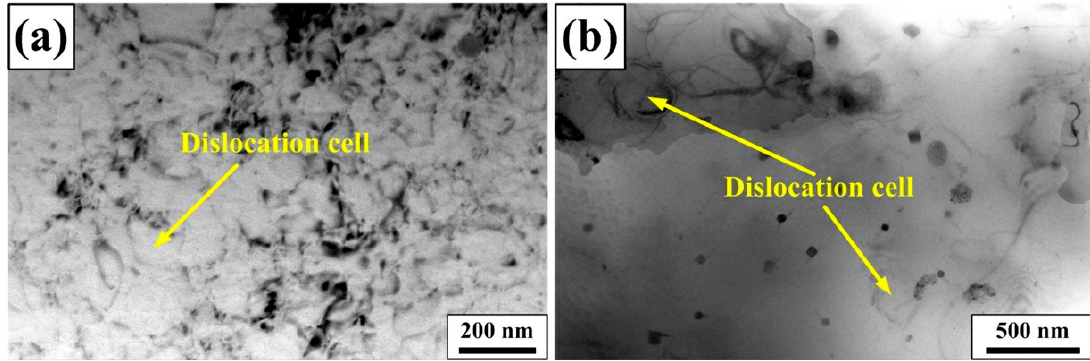
Figure 10. TEM observation showing morphology of dislocation cell of different samples: ( a ) S, ( b ) T6.